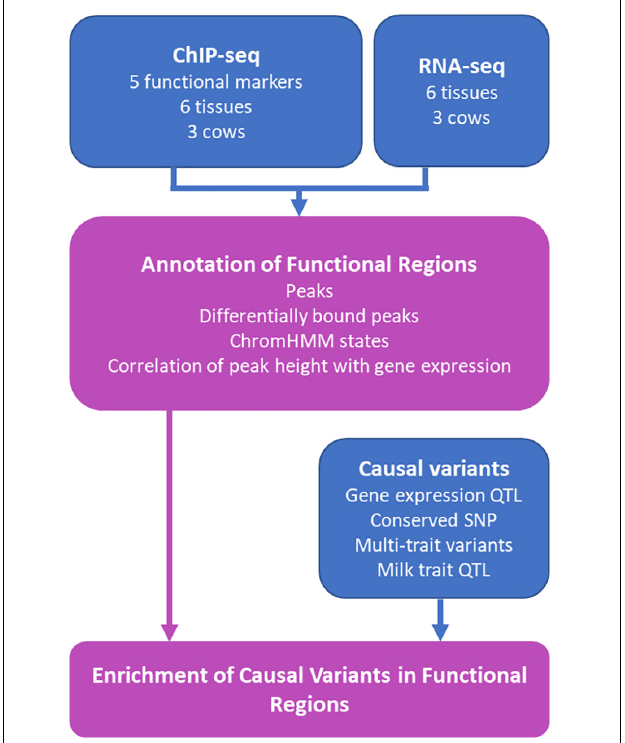
FIGURE 1 | Schematic of Study. Results from the study are outlined in purple boxes while data sources contributing to the results are represented in blue. RNA-seq and ChIP-seq data was generated from heart, liver, lung, kidney, mammary gland, and spleen from the same three cows. The five functional markers assayed were H3K4Me1, H3K4Me3, H3K27Me3, H3K27ac, and CTCF. Details of causal variants are outlined in Table 1